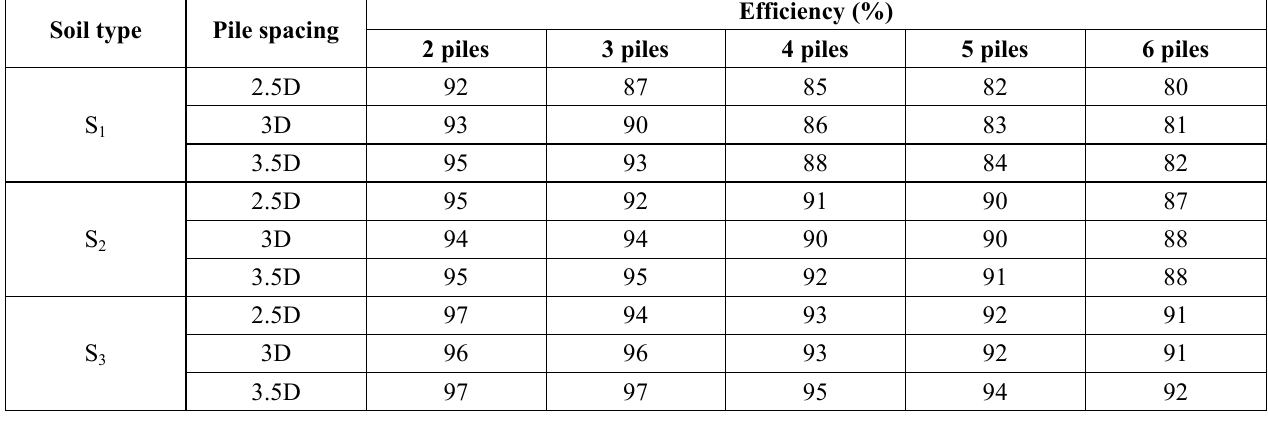
at different pile spacing under three soil types. 600